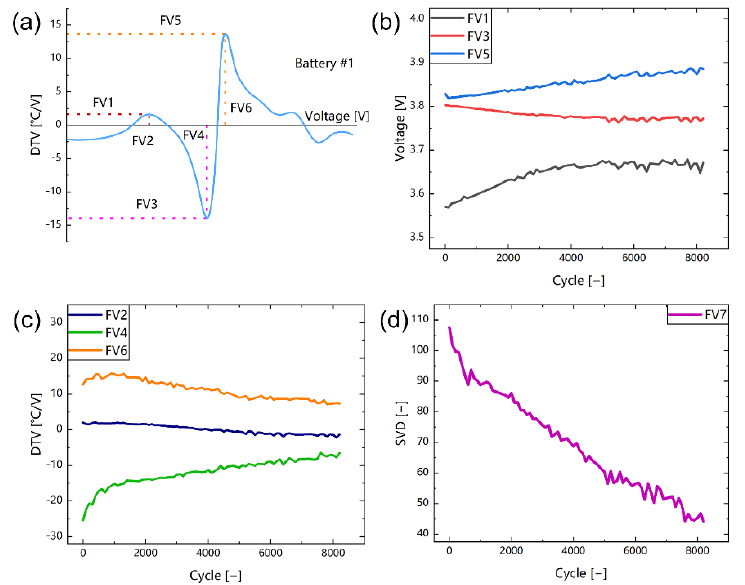
Figure 5. DTV curves and feature variables of the battery #1 under different cycles. ( a ) Features extraction from DTV curves under different cycles. ( b ) Extraction features of FV1, FV3 and FV5 with the cycle number. ( c ) Extraction features of FV2, FV4 and FV6 with the cycle number. ( d ) Extraction features of FV7 with the cycle number.